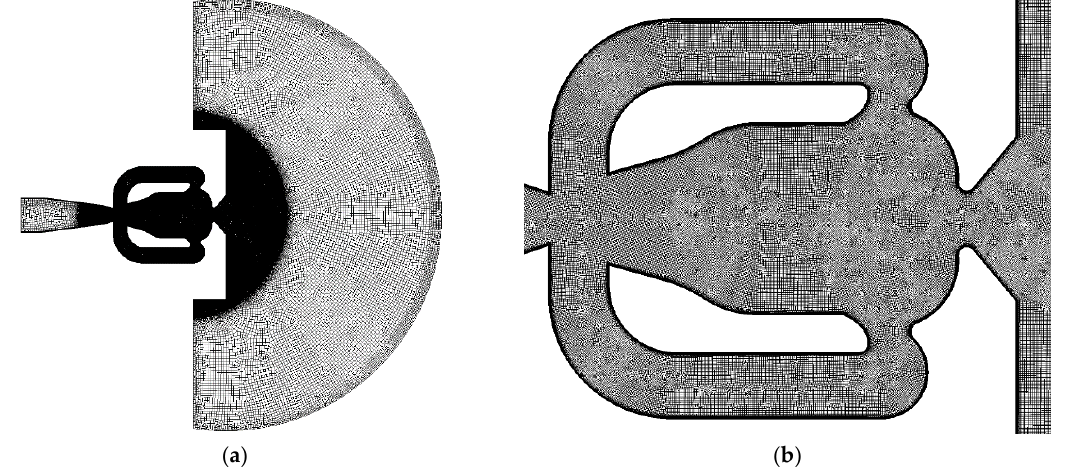
Figure 2. Computational mesh (N40). ( a ) Computational domain (XY plane) and ( b ) close-up view of the sweeping jet actuator mesh. Even with the close-up view, the boundary layer mesh (25 layers) seems like a thick black line. Reproduced with permission from [9].